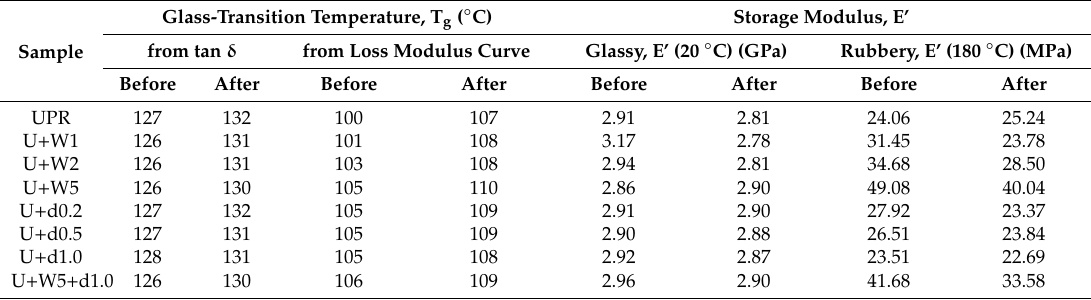
Table 4. Glass-transition temperature and storage modulus in the glassy and rubbery regions (from the storage modulus curve) data of green composites before and after the accelerated aging test.